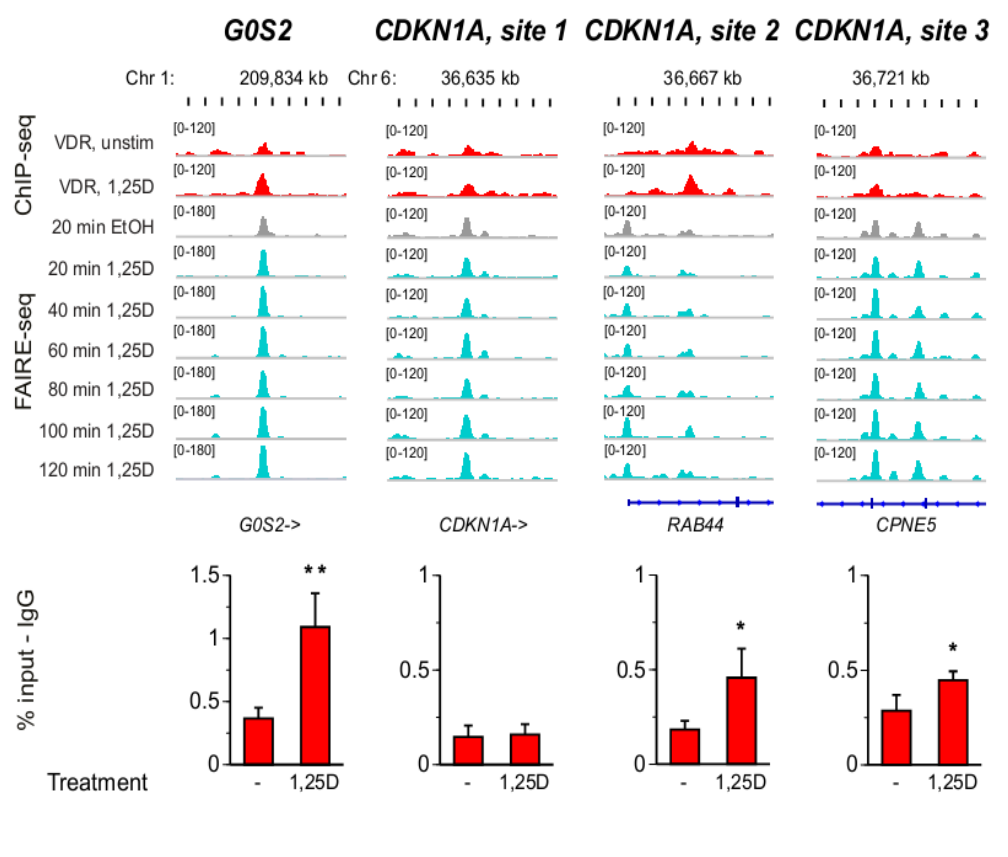
Figure 3. Detailed genomic view on VDR association and open chromatin. The